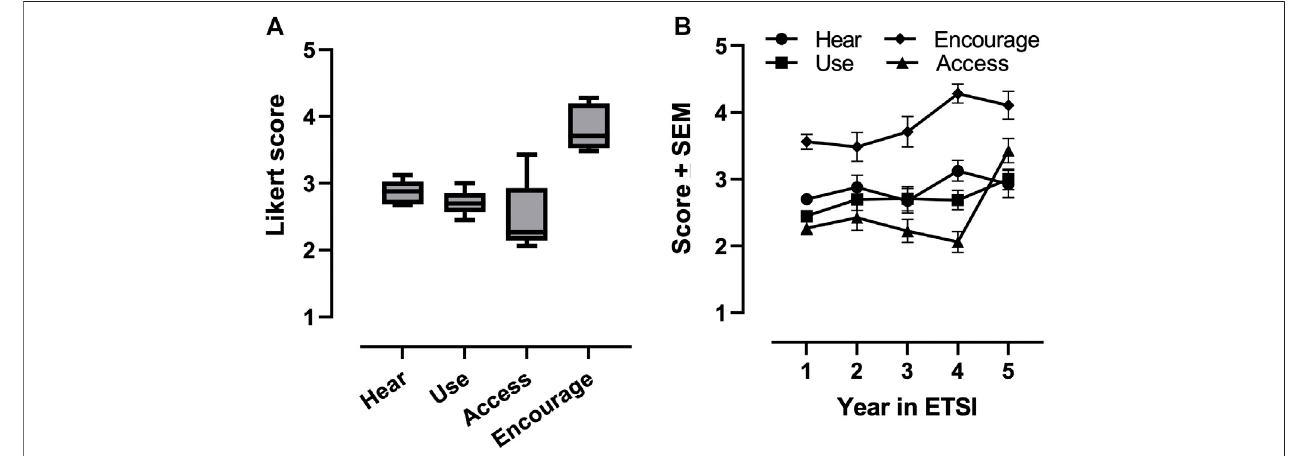
FIGURE 2 | Monastic students ’ science learning behaviors at Sera Jey Monastic University (2018 study) (A) Willingness to encourage fellow monastic students to study science was rated signi fi cantly higher on a Likert-type scale of 1-5 than practical behaviors of hearing science words, using science terms, and accessing science content outside ofETSI ( n (cid:1) 214). (B) Disaggregated by year of study in ETSI, monasticstudent levels ofengagement increased as a function ofyears in the program. In particular, accessing science materials signi fi cantly increased with Year 5 students compared to all other years; p < 0.0001; Tukey ’ s test. Each symbol is representative of a different science learning